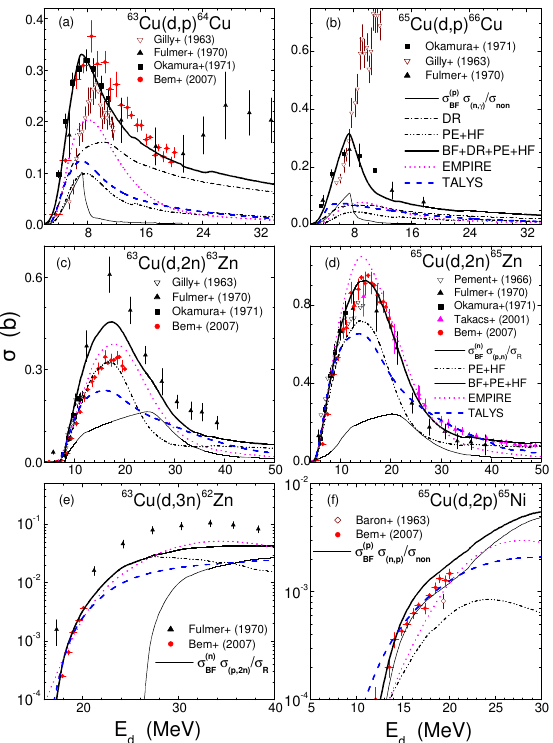
Fig. 3. (Color online) Comparison of measured [3] and calcu- lated reaction cross sections provided by the EMPIRE(dotted) and TALYS (dashed) codes, and present analysis (thick solid) taking into account the deuteron inelastic breakup (thin solid), the DR (dash-dotted) , and the PE + CN (dash-dott-dotted) mech- anisms contributions to the deuteron interaction with 63 , 65